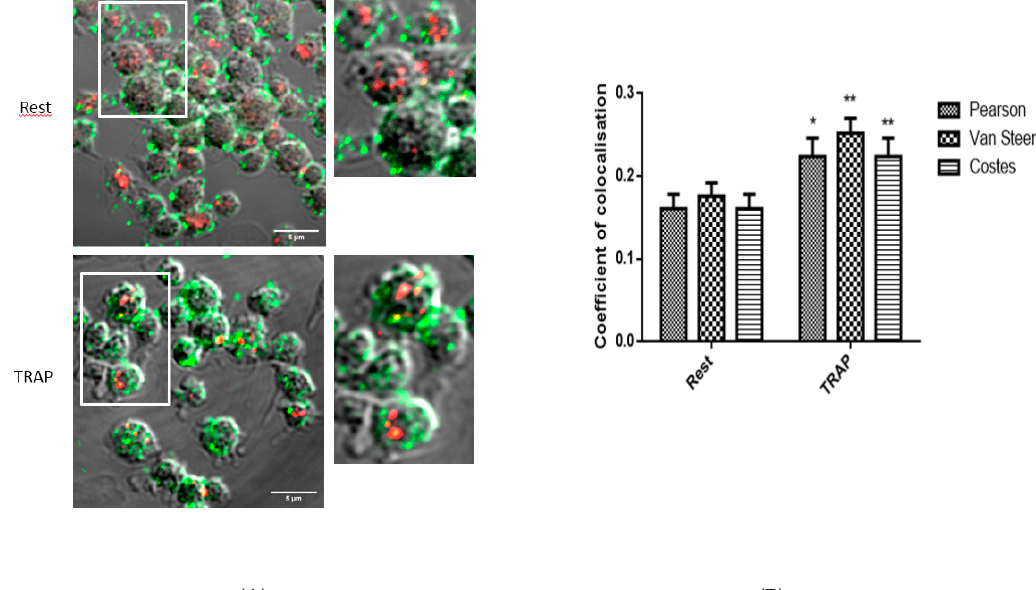
Figure 2. Weak colocalization of PAR1 and cholesterol-rich microdomains in human platelets. ( A ) Double staining of PAR1 (green) and cholesterol-rich microdomains (red) showing no significant colocalization of PAR1 in cholesterol-rich microdomains in resting (Rest) platelets and a weak but significant increase of colocalization in TRAP-stimulated platelets. Images shown are representative of five independent experiments (15 images were analyzed). The insets show an enlargement of the indicated region (scale bar = 5 µm). ( B ) Statistical tests for measures of colocalization between PAR1 and cholesterol-rich microdomains confirm a weak but significant increase in TRAP-activated platelets. This colocalization remained low as the coefficient of colocalization measured by different tests including Pearson’s, Van Steensel’s, and Costes’ was lower than 0.5. * p < 0.05, ** p < 0.005 (according to a student t test), n = 5.